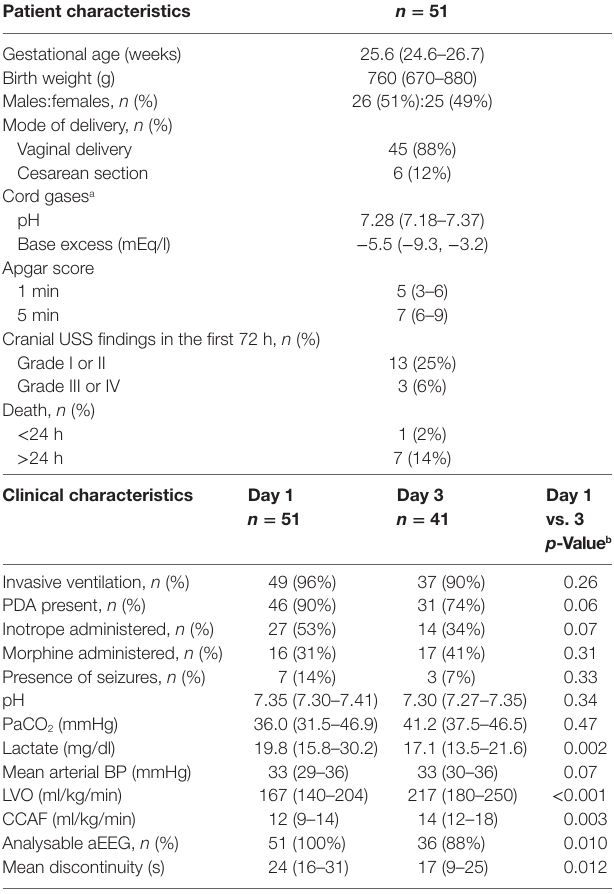
TaBle 1 | Patient and clinical